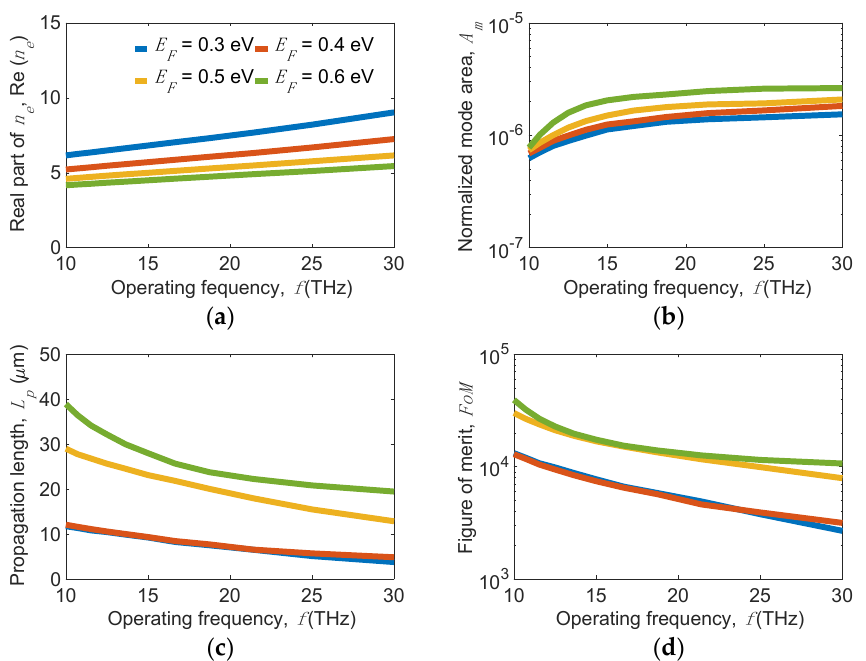
Figure 12. Plots of ( a ) real part of effective index n e , Re( n e ), ( b ) normalized mode area, A m , ( c ) propagation length, L p , and ( d ) figure of merit, FoM, of the present structure versus the operating frequency, f , for several values of E F when w g = 200 nm, w r = 10 nm, h r = 30 nm, t Si = 5 nm, and t d = 5 nm.